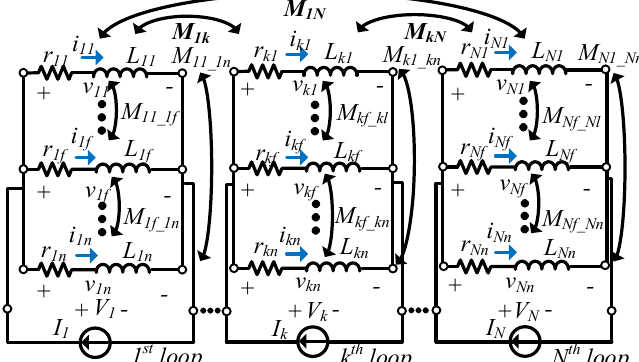
Figure 3. An equivalent circuit of a printed spiral coil with N turns.